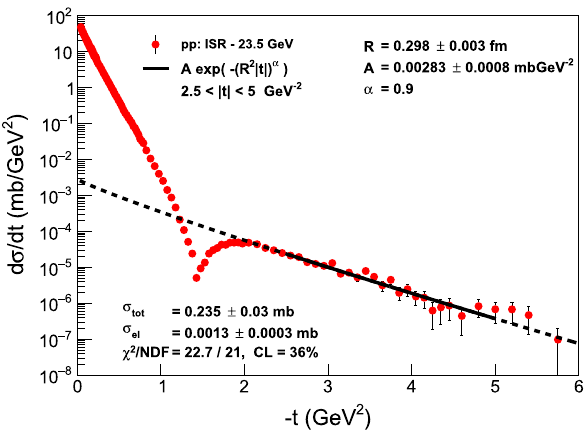
Fig. 30 Zeroth-order Lévy fits to the tail of the differential cross- √ s = 23 . 5 GeV [45], with section data on pp elastic scattering at fixed α = 0 . 9, A and R as free fit parameters